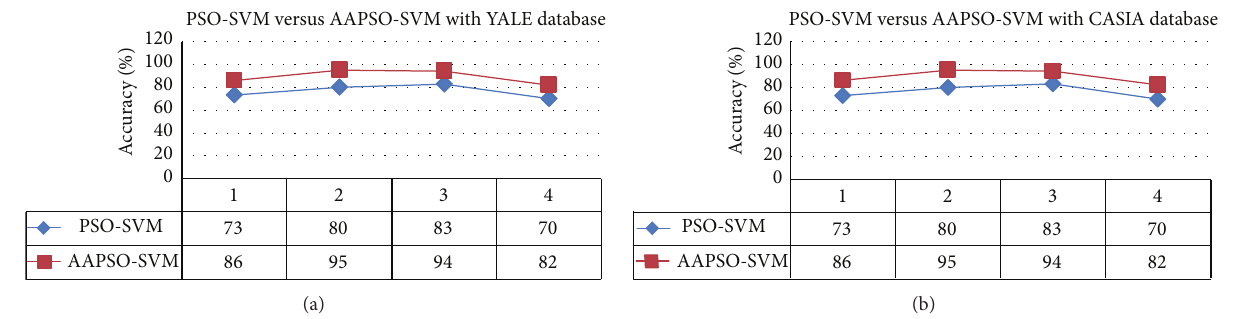
Figure 8: Performance accuracy of theAAPSO and PSO recognition methods from (a) YALE [5] database and (b) CASIA [6]